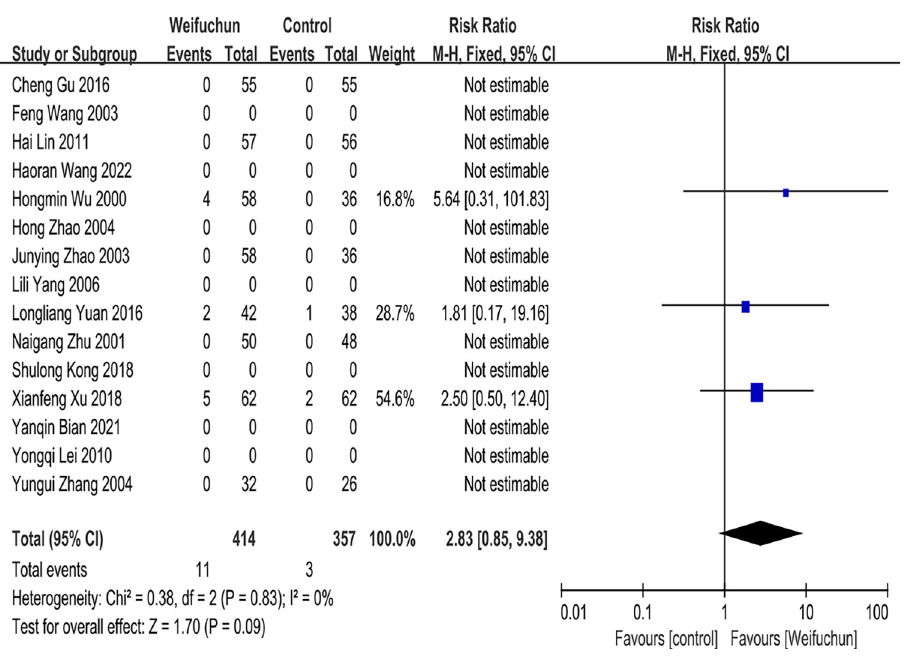
Fig 10. Forest plot of safety